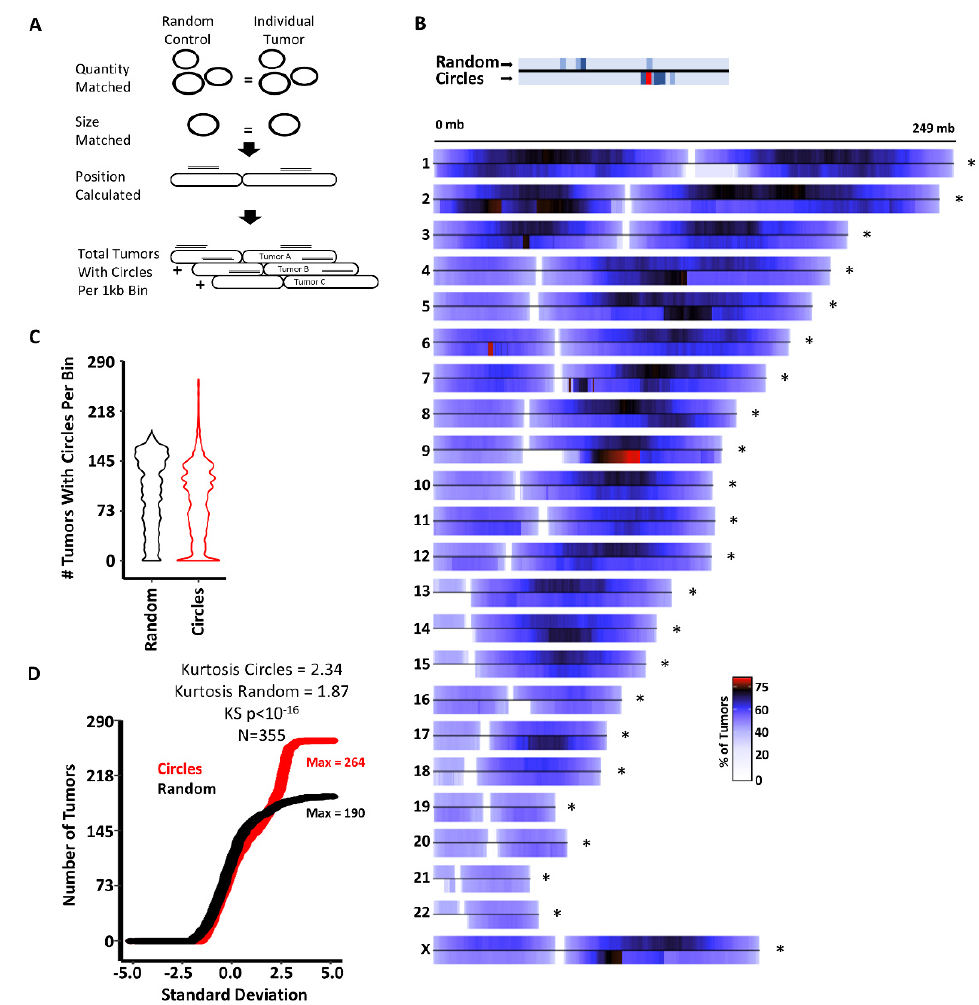
Figure 1. DNA circles are found at common loci irrespective of tumor type. ( A ) Schematic depicting the analysis for each of the 355 TCGA tumor samples. Random circles were constrained to non- centromere locations and forced to generate the same number of and size of real as each individual tumor. ( B ) Pan-cancer analysis of circles show many tumors have common genomic locations with circles. Top of each chromosome represents the distribution of random circle controls. Below the line represents true circles from TCGA samples. The transition from red to black indicates greater than 75% of samples with a circle in the bin. The coordinates for regions with circles in 191 or more tumors are reported in Table S1. ( C ) Distribution of the 3 million 1 kb bins with the number of samples with circles in each bin. ( D ) QQ analysis of the distribution of bins by number of samples. Significance of the overall distribution was assessed by KS test and the deviation of bins with high numbers of samples was assessed by Kurtosis. p -values less than 0.05 were considered significant. An * next to a chromosome indicates a p -values less than 10 − 16 by KS for that